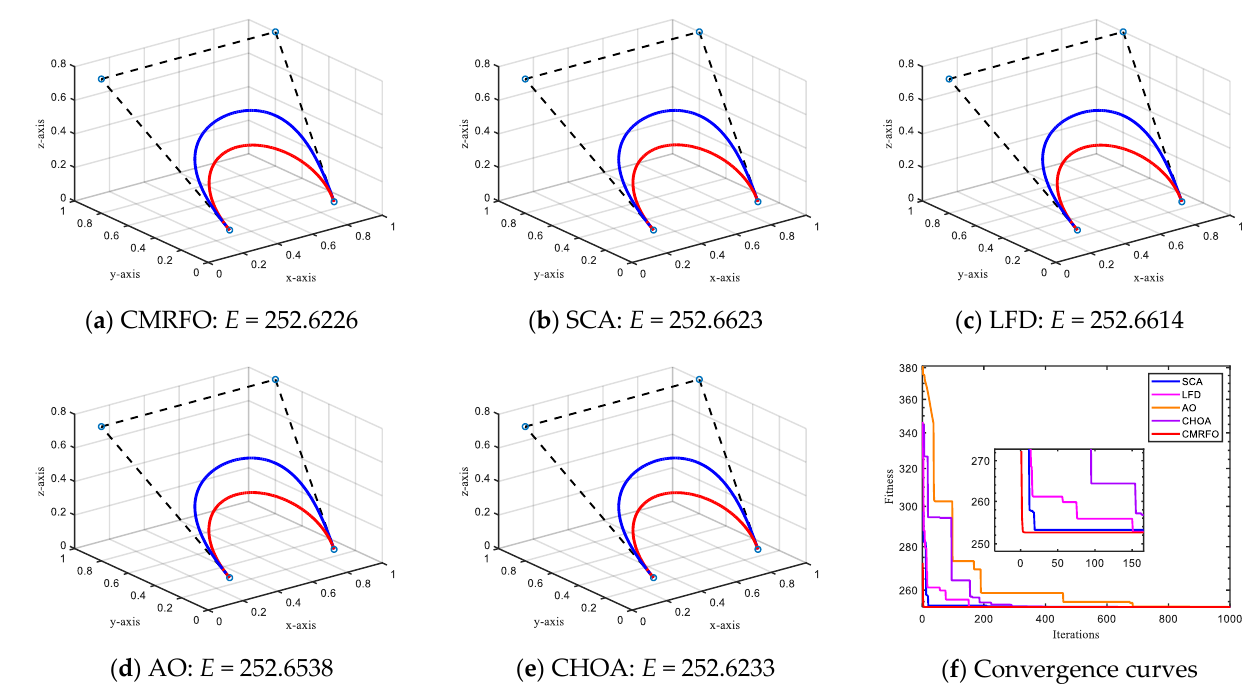
Figure 12. Shape optimization of CG-Ball curves. Table 17. Optimal values of shape parameters and corresponding fitness value.